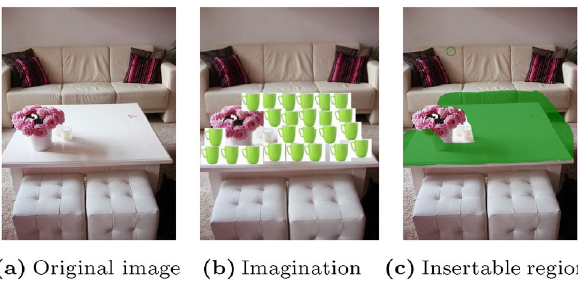
Fig. 1 Method for drawing the insertable region. This illustration was presented to the annotators when explaining the task to them. Note that, due to the size of the cup, some pixels above the table should also be